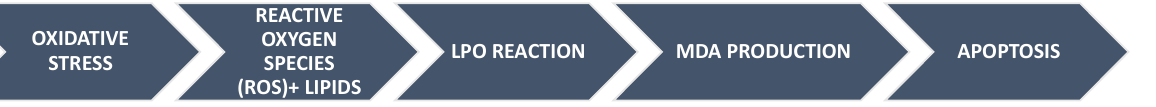
Figure 1. Representation of oxidative stress cascade and its effects.LPO: lipid perodixation. ROS: reactive oxygen species. MDA: Malondialdehyde.